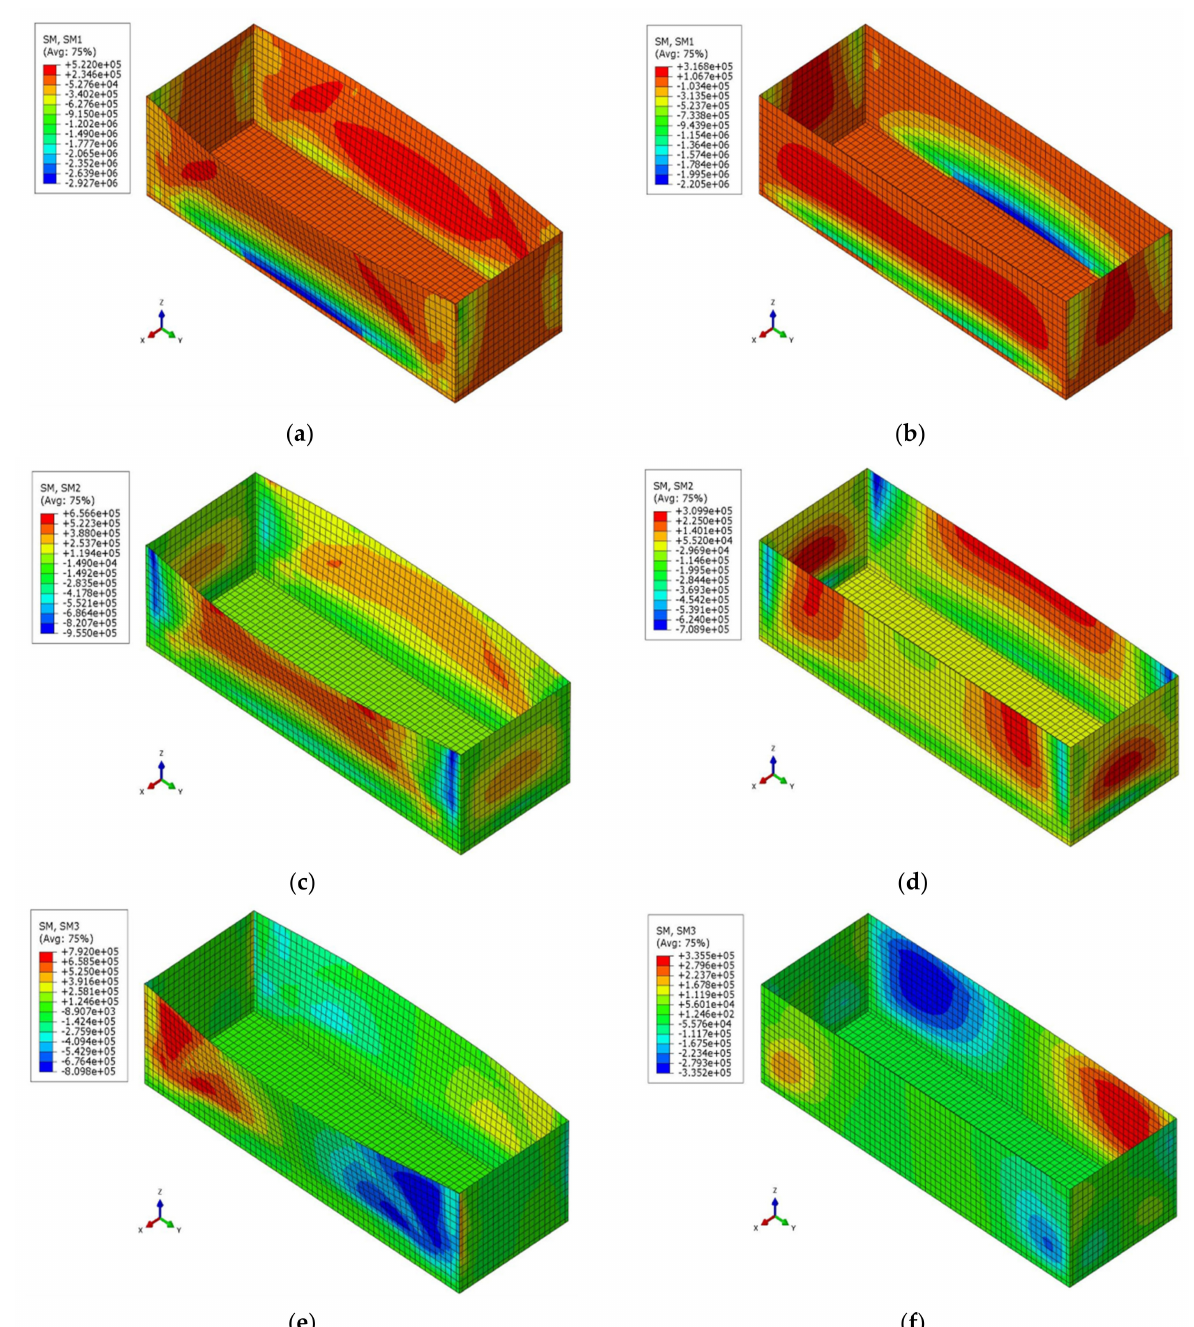
Figure 7. Section moments of the tank structure: ( a ) SM1 from nonlinear analysis; ( b ) SM1 from linear analysis; ( c ) SM2 from nonlinear analysis; ( d ) SM2 from linear analysis; ( e ) SM3 from nonlinear analysis; ( f ) SM3 from linear